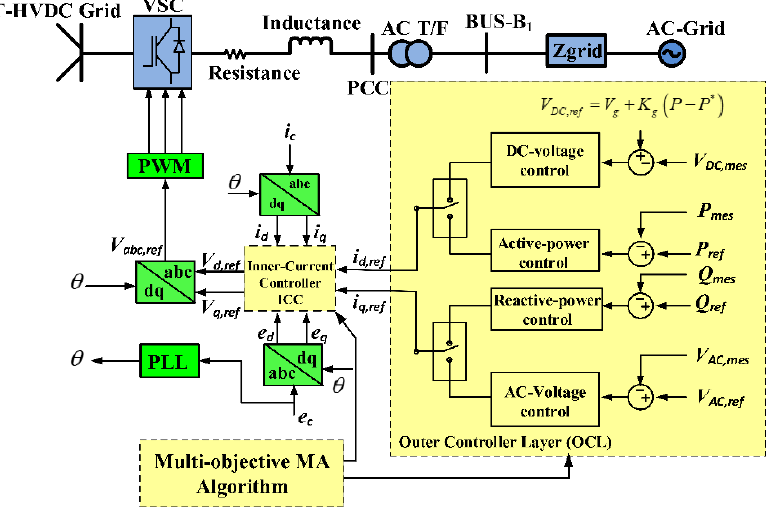
Figure 12. VSCs multi-objective tuning using MA .